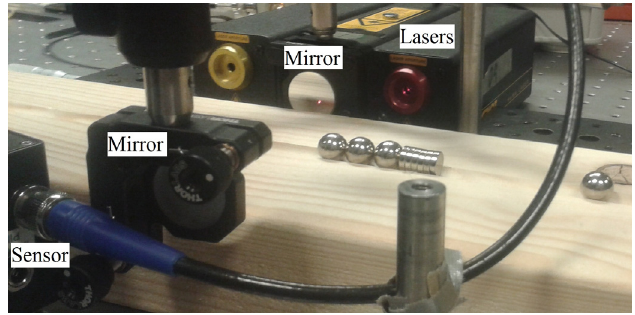
Fig. 2. An experimental setup used to measure speed. The Gaussian cannon is resting on a wooden track. A trigger ball is approaching the cannon from the right and on the left lasers are arranged in order to measure the fi